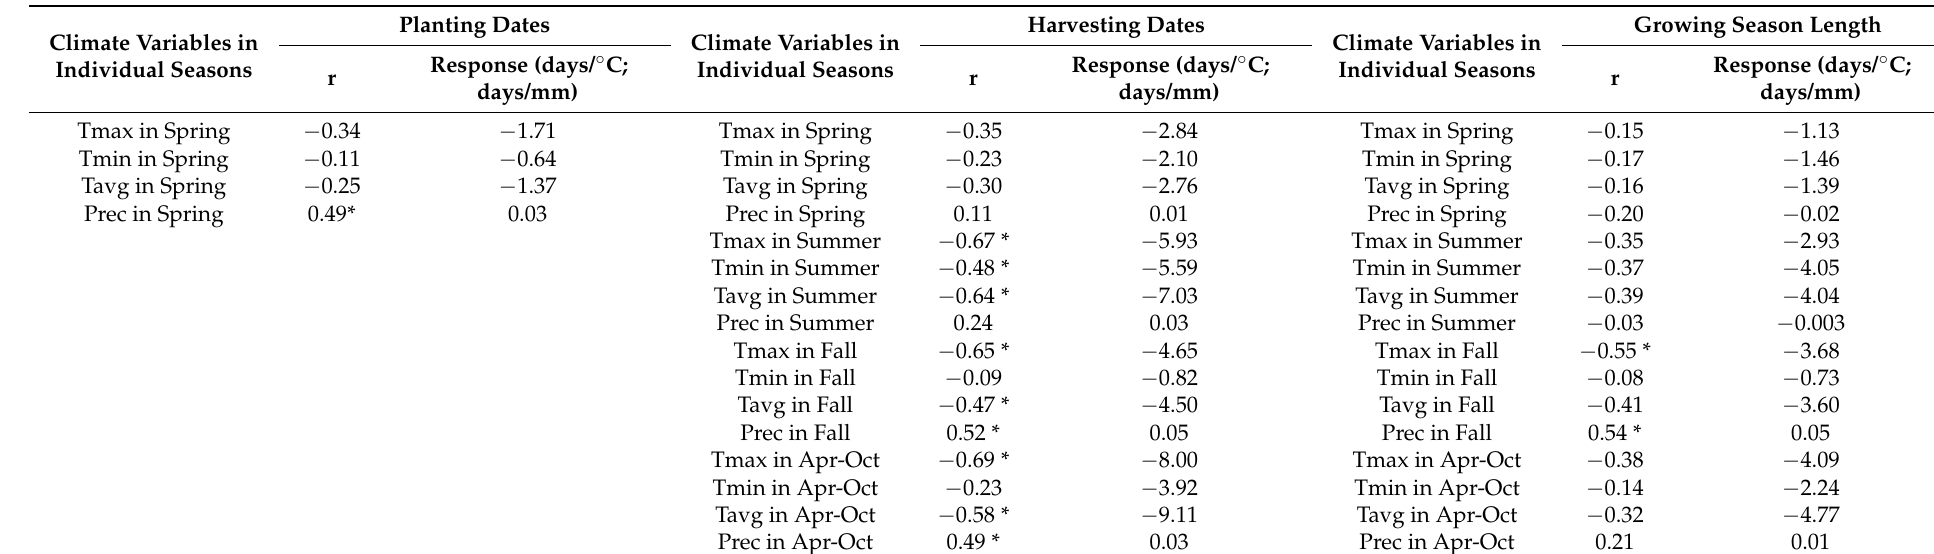
Table 5. Correlations between soybean phenology and climatic variables in Kentucky,